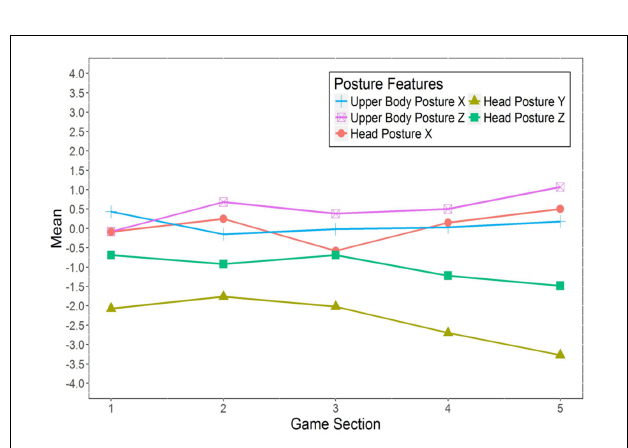
FIGURE 5 | Changes in the posture features of bodily expression during playing Cure Runners . Means multiplied by 100. n = 32.